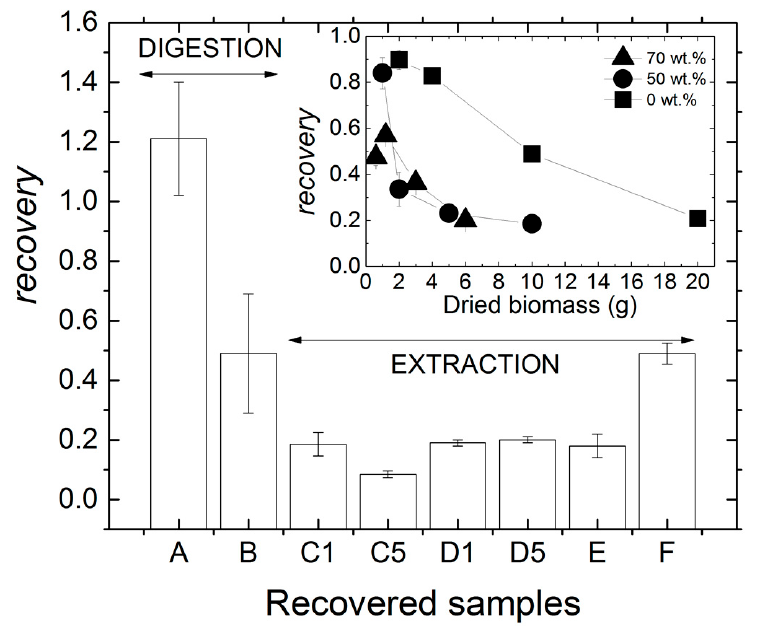
Figure 3. Product recovery achieved for all processed biomasses. Samples produced for benchmark- ing are: A for digestion with NaOH, and E and F for extraction in CHCl 3 . Inset: product recovery as a function of the dried biomass weight used for the extraction with CHCl 3 of MMC